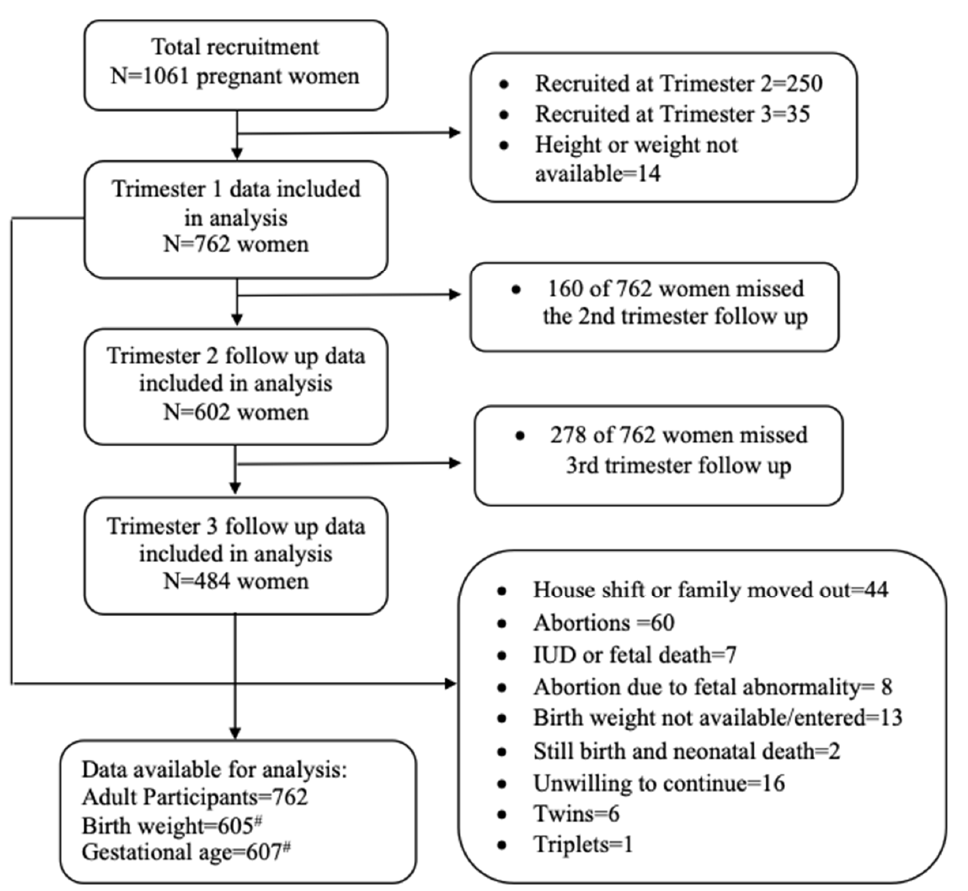
Figure 1. Flowchart of the participants in the longitudinal cohort study. For data analysis, only participants who were enrolled in Trimester 1 were considered ( n = 776), of which 14 women had either height or weight missing and were excluded from final analysis as BMI could not be calculated. # Total number of children whose birth weight was available = 934. However, of the 762 women included in analysis, birth weight was available only for 605 infants, and gestational age was available for 607. Missing data accounted for subjects untraceable due to house relocation during delivery, intra-uterine death (IUD), neonatal death, termination of pregnancy, withdrawal from study, birth weight data not entered or not available as the participant went away to maternal home for delivery and multiple